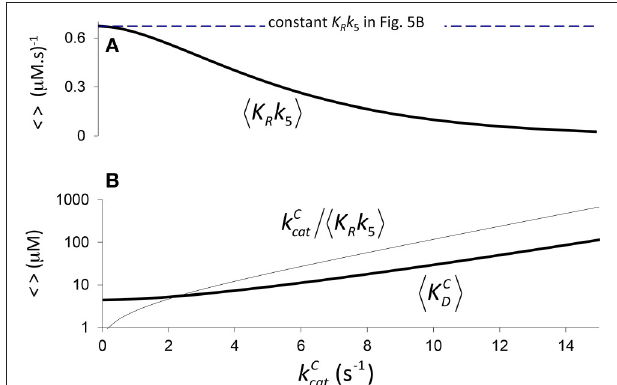
K R k 5 FIGURE 4 | Components of K C if correlation is due to CO 2 binding. (A) = 3s − 1 (cid:10) (cid:11) Equation (4) calculated assuming a constant value of γ C k 6 (cid:10) (cid:11) ( Figure 2B , a 1 = 4.5 µ M, b 1 = 0.34s), and (B) the corresponding C cat h K C D K C Equation (5), derived from Equation components of , i.e. k K R k 5 i and D E FIGURE 6 | Selection of S C / O data from Table 1. The symbols in black are (cid:10) (cid:11) from the compilation of Savir et al. (2010). The S C / O value for N . tabacum L335V mutant is shown. Also on the graph is Equation (10), including a possible factor of Equation (10),